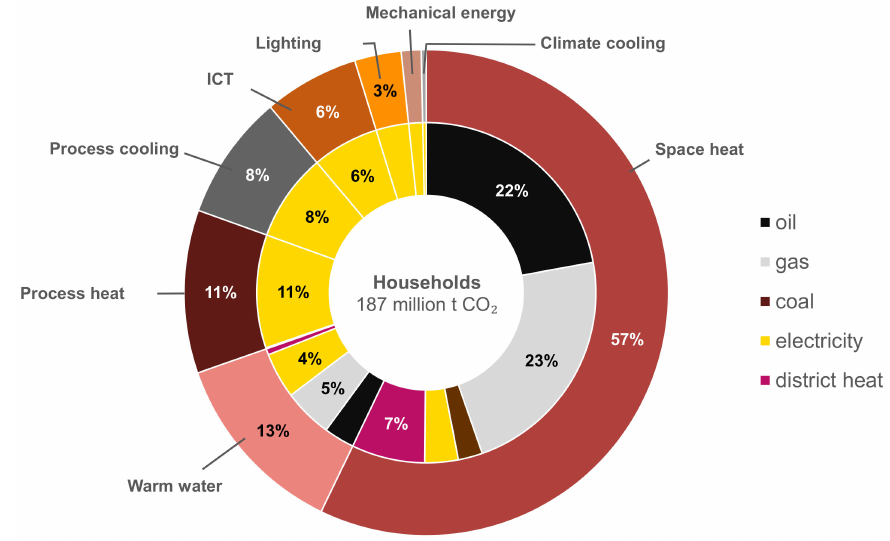
Figure 1. Emissions caused by domestic sector in 2014 (temperature